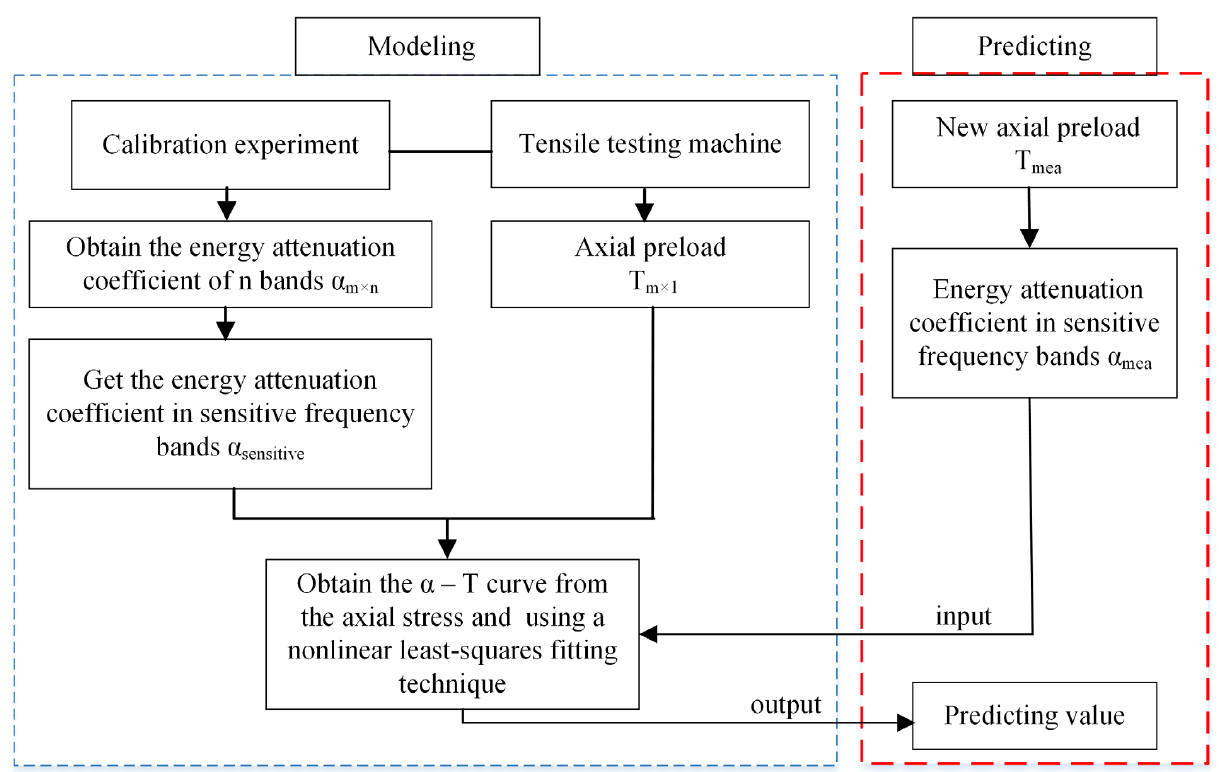
Figure 6. Modeling and predicting process.